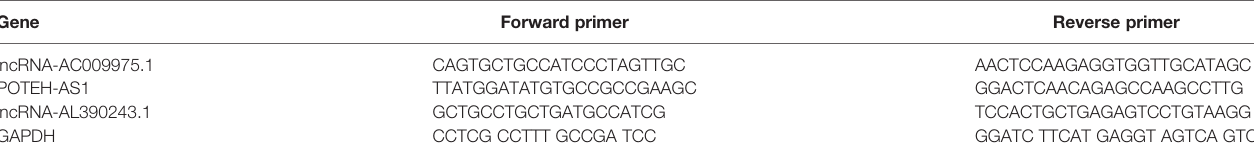
TABLE 2 | The qPCR primers. Gene Forward